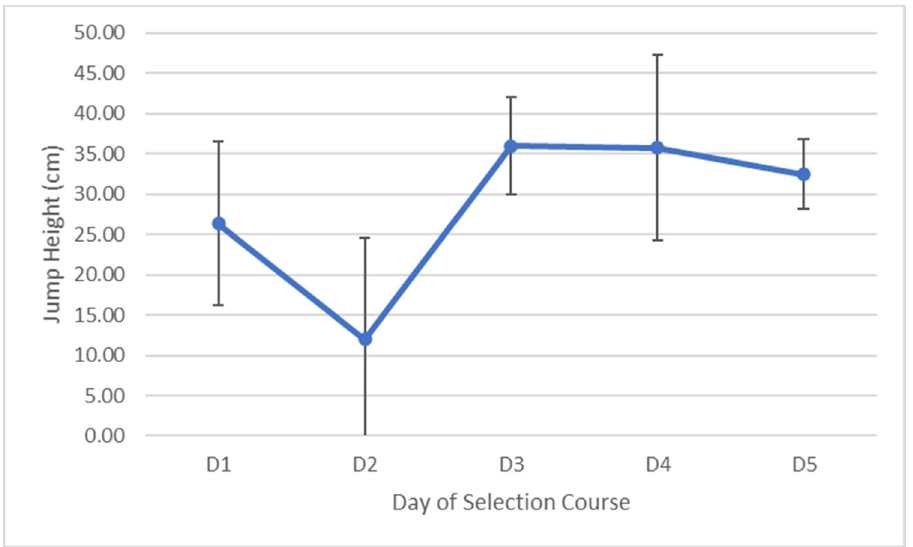
Figure 4. Average changes (±SD) in vertical jump height as measured by a vertical jump assessment over the five days.